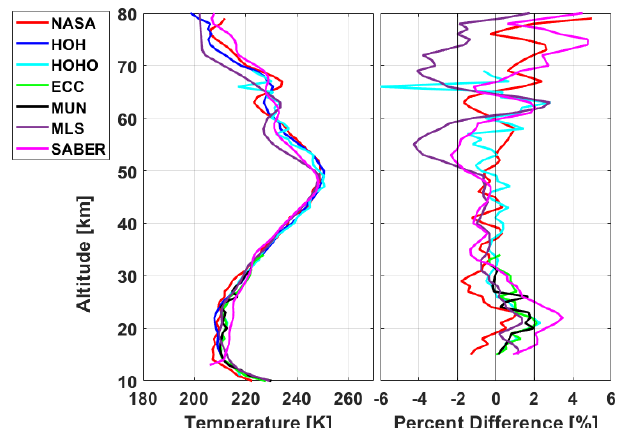
Figure 3. Temperature profiles measured by the NASA-STROZ (red), HOH (blue), and HOHO (cyan) lidars, locally launched ozonesonde (green), Munich meteorological radiosonde (black), and overpasses from MLS (violet) and SABER (magenta) on the night of 21 October 2018. Percent differences are with respect to the HOH lidar.